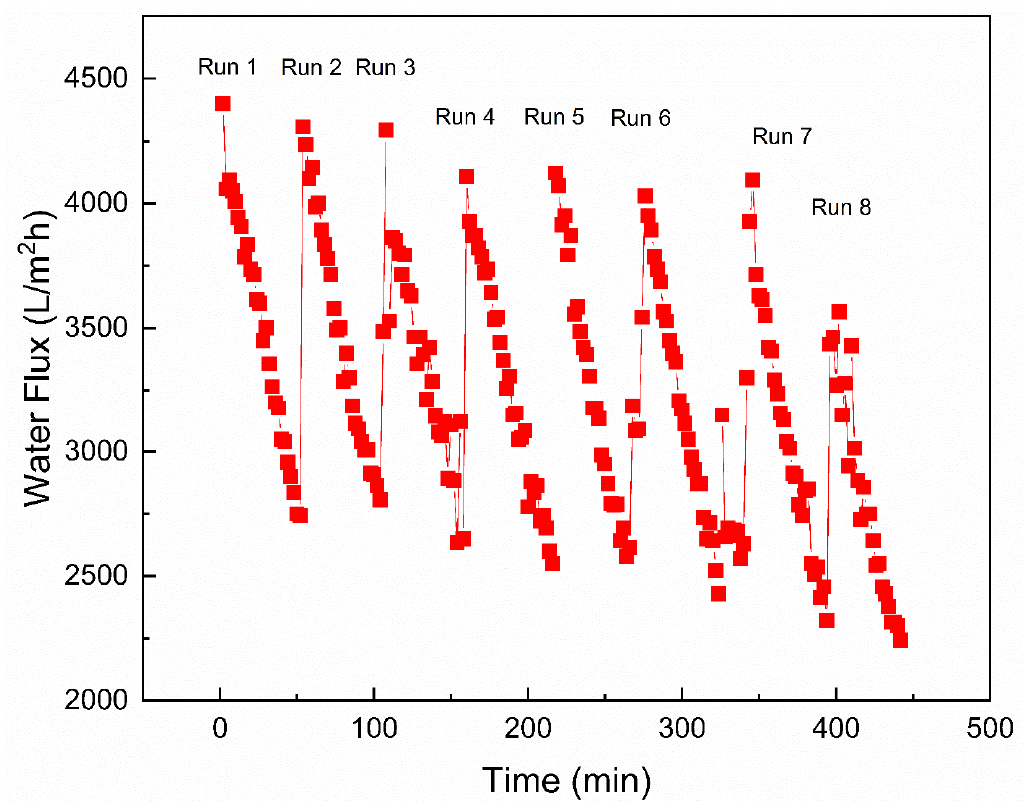
Figure 12. Water flux (L/m 2 h) of the 0.05-GQD/PA TFN membranes during long-term performance analysis—eight runs, i.e., 7.5 h in total.